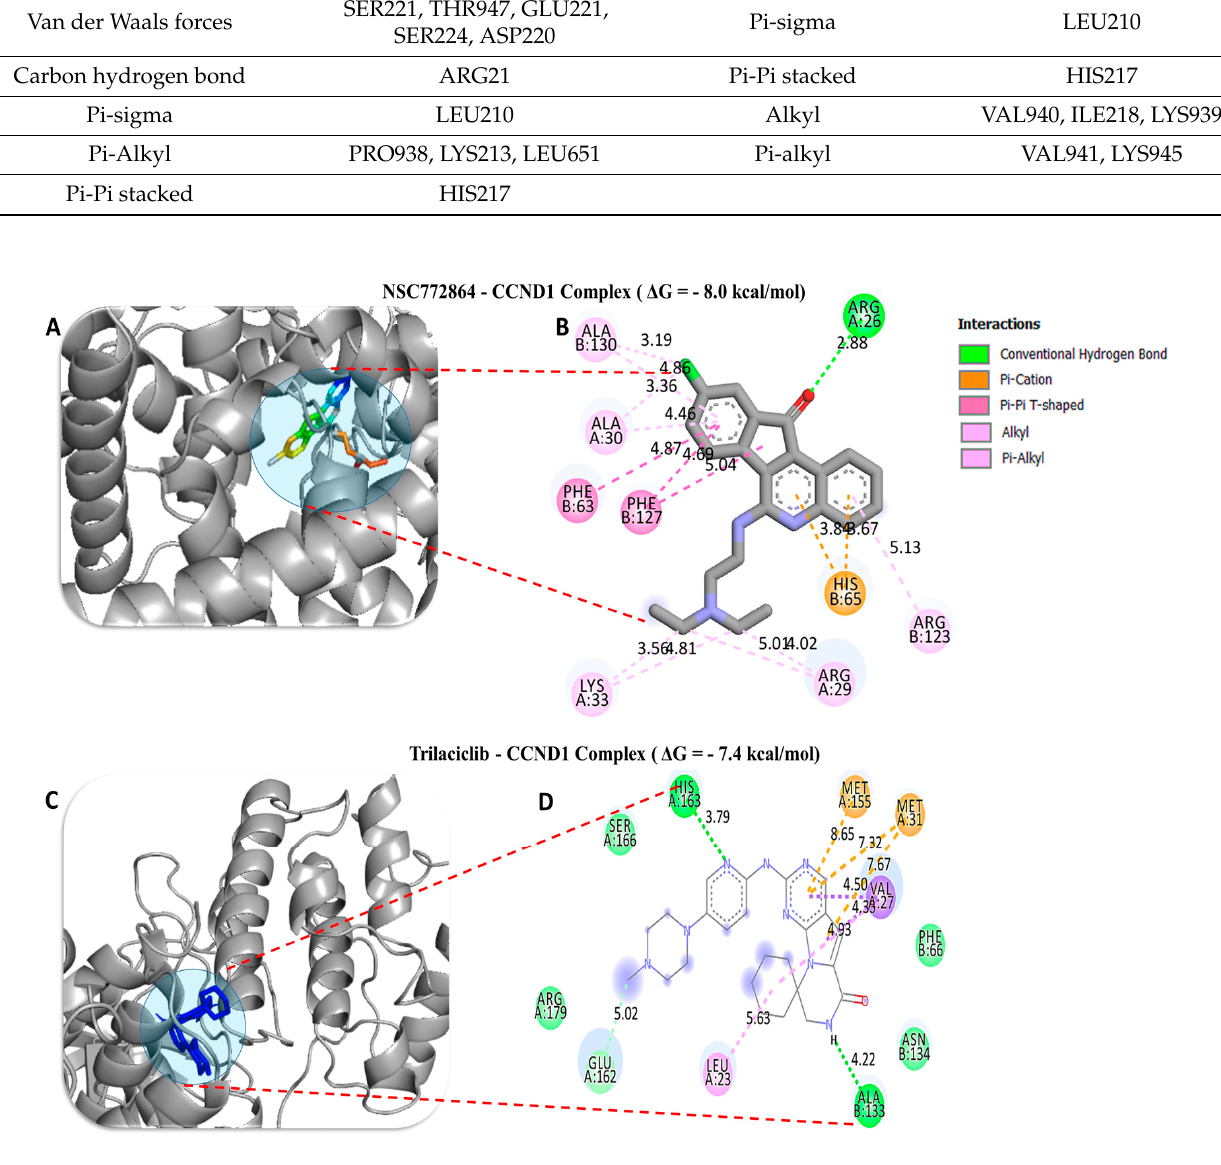
Figure 15. Docking profiles of cyclin D1 (CCND1) with NSC772864 and standard inhibitors. ( A , B ) NSC772864 bound to CCND1 with Gibbs’ free energy ( ∆ G) of − 8.0 kcal/mol. ( C , D ) Binding of trilaciclib with c-Met showed a slightly higher affinity at ∆ G = − 7.4 kcal/mol compared to NSC772864. Table 6 gives the binding energies of ligand–receptor interactions, including different types of interactions and the amino acid residues involved. Table 6. NSC772864 and standard drug comparative docking profiles against c-MYC.